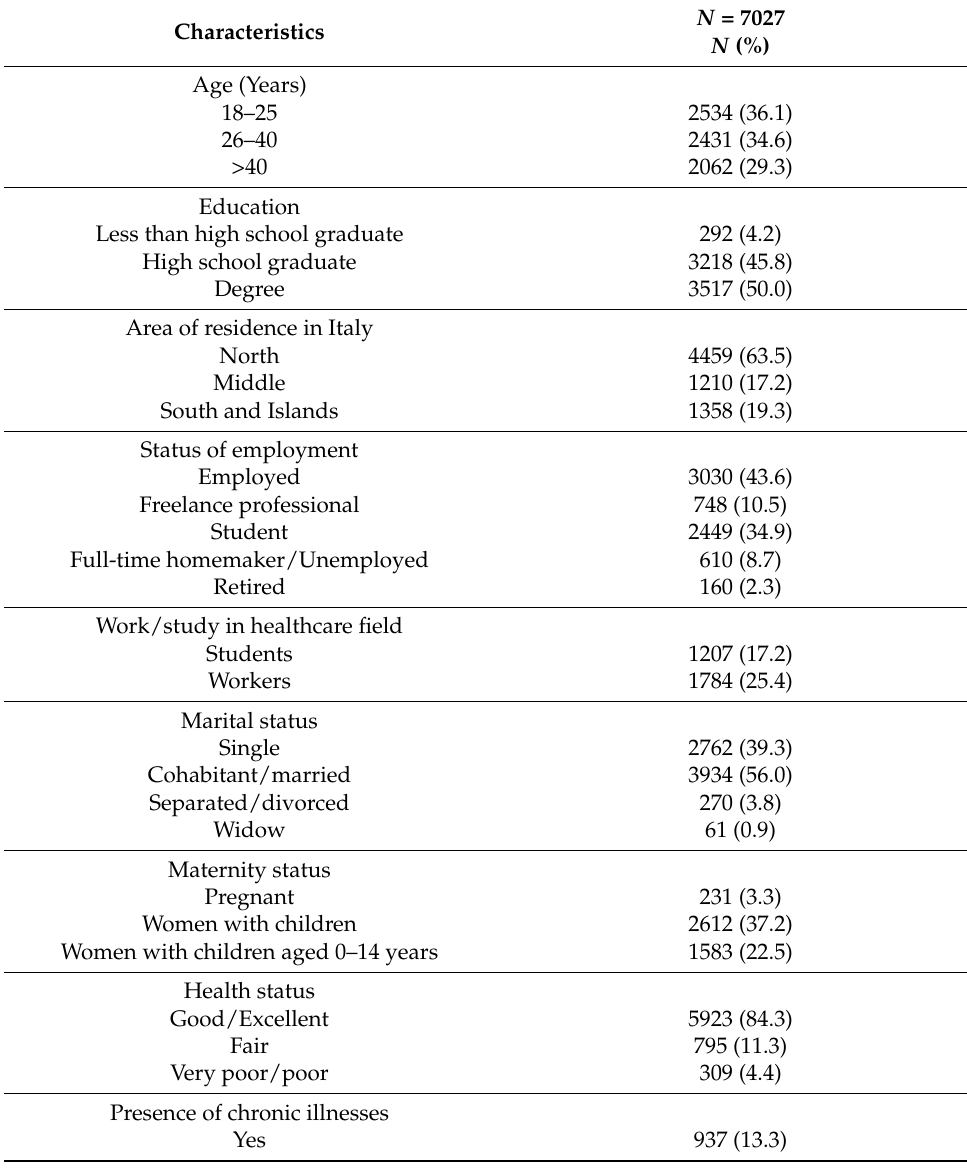
Table 1. Characteristics of online